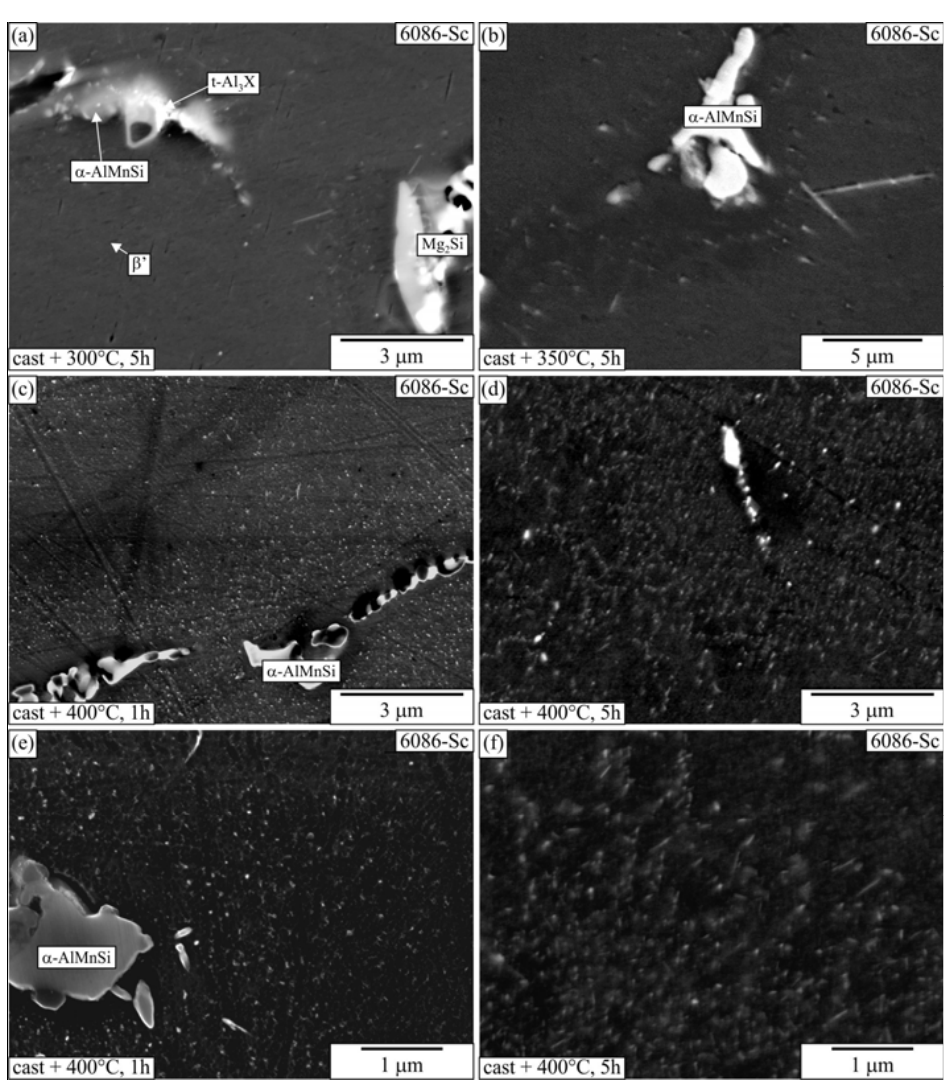
Figure 19. Microstructures of the 6086-Sc after T5 heat treatment of the as-cast samples at different temperatures and durations (backscattered electron micrographs, sample diameter 10 mm). ( a ) 300 ◦ C, 5 h, ( b ) 350 ◦ C, 5 h, ( c ) 400 ◦ C, 1 h, ( d ) 400 ◦ C, 5 h, ( e ) 400 ◦ C, 1 h, ( f ) 400 ◦ C, 5